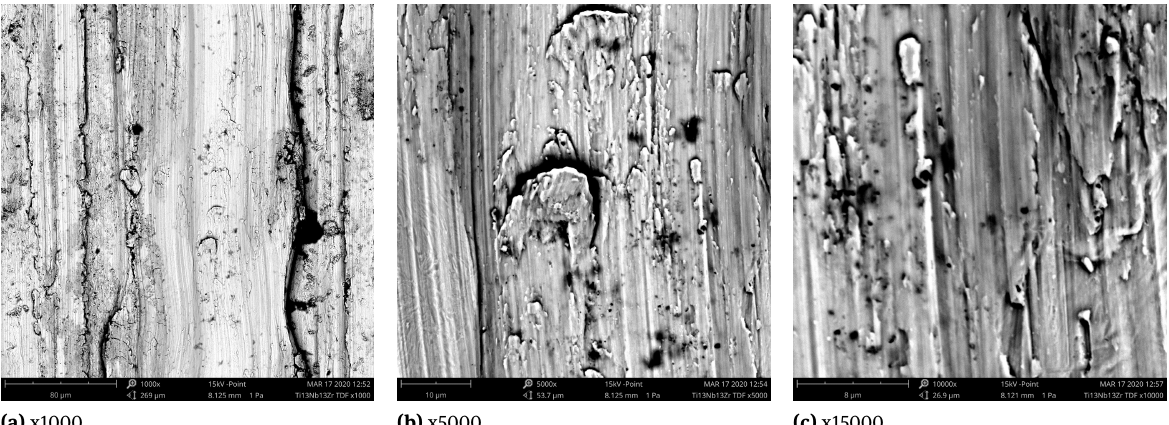
Figure 8: Surface morphology of the wear traces after techncal dry friction (TDF) for Ti13Nb13Zr